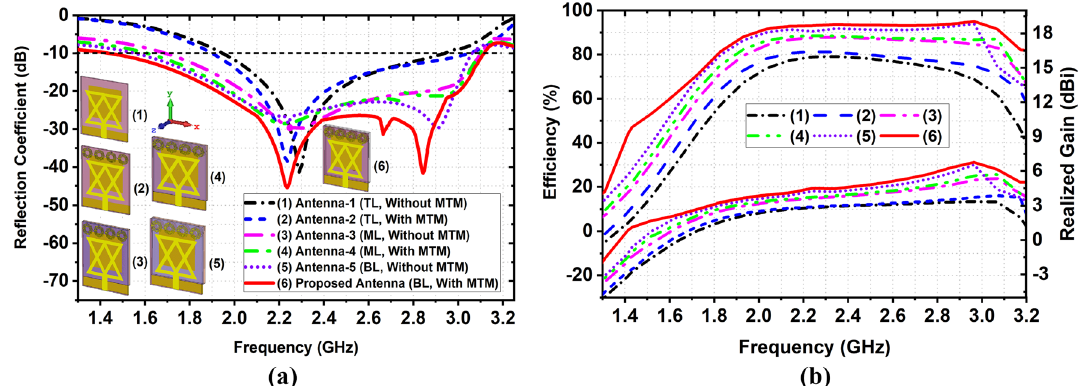
Figure 4. Simulated results of the different antenna design: ( a ) Reflection coefficient; ( b ) Efficiency versus Realized gain.